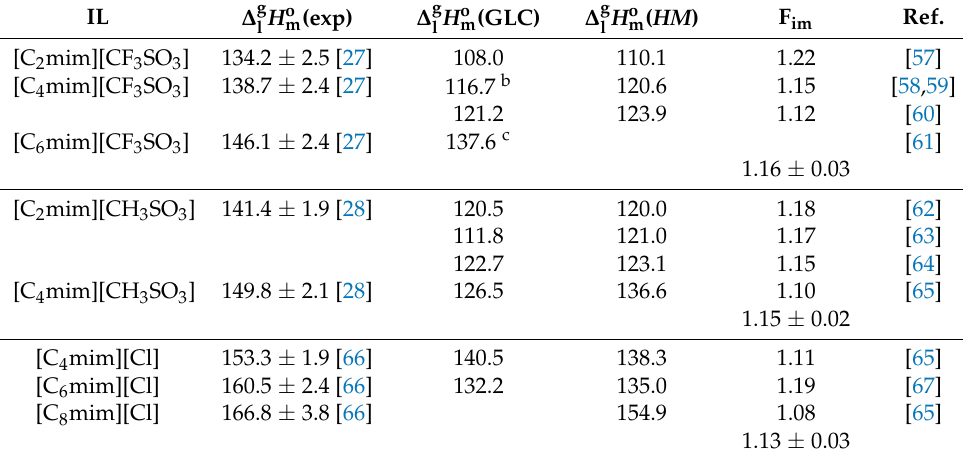
(298.15 K) values derived according to Equations (5) and (6) with experimental results from conventional methods a